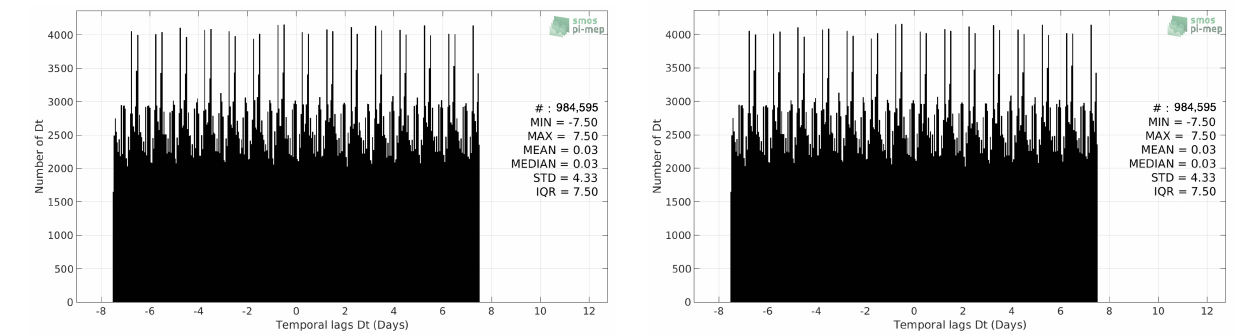
Figure 7. Histograms of the spatial ( left ) and temporal ( right ) lags between the location/time of the Argo measurement and the position/date of the corresponding CCI SSS L4 Merged-OI v3.2—30-day running (ESA) SSS pixel.